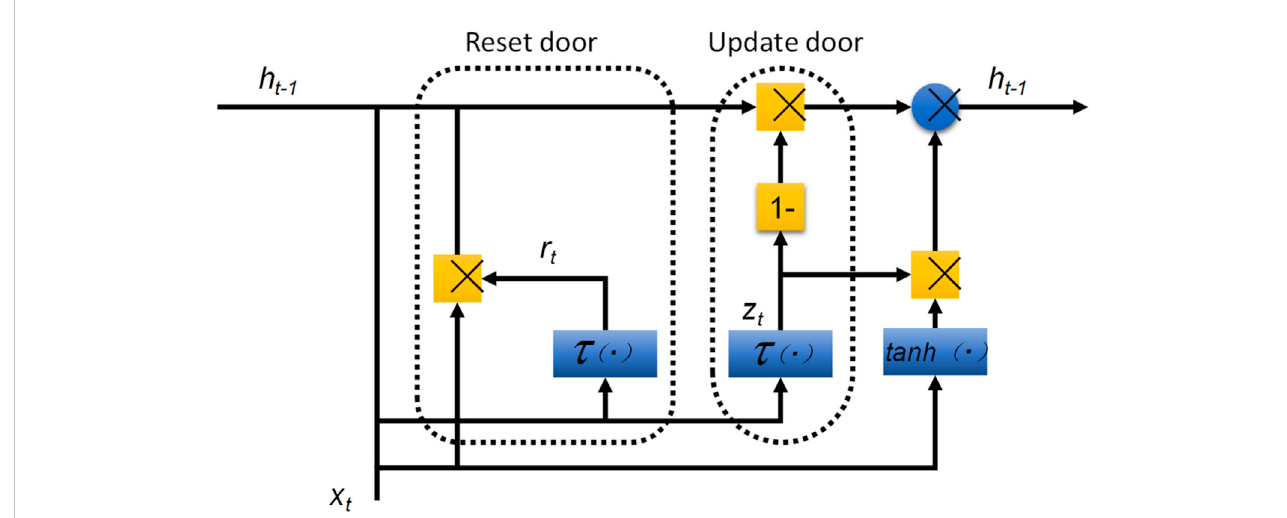
FIGURE 1 Internal structure of GRU.